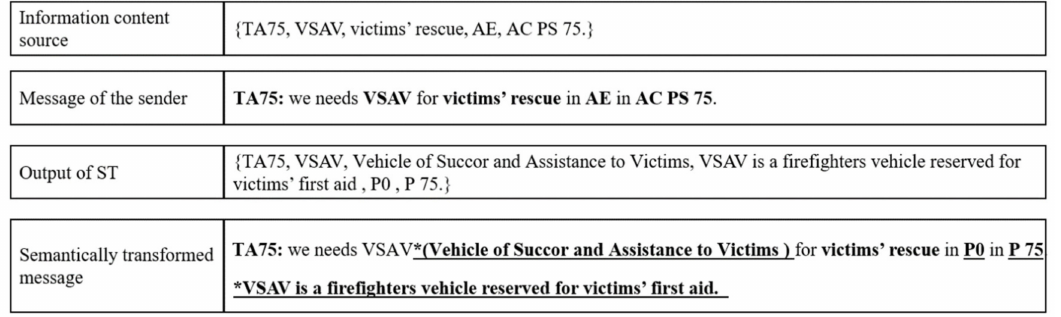
Figure 25. Message transformation